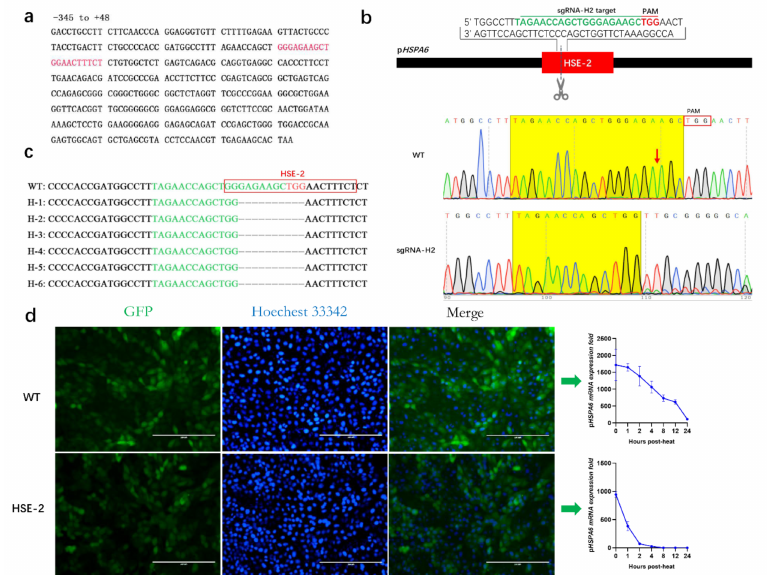
Figure 3. Effect of HSE-2 on the expression of p HSPA6 . ( a ) The position of HSE-2 was located in the p HSPA6 promoter. ( b ) Strategy of sgRNA-H2 knock-in into p HSPA6 ; and the cutting efficiency of sgRNA-H2 was evaluated using chromatograms. Red blocks and red arrows represent PAMs and cleavage sites, respectively. ( c ) Diagram of positive clone HSE-2 after pLB vector cloning. ( d ) Fluorescence microscopy and qPCR analysis of p HSPA6 expression in WT and positive clone cells (data show the mean ± S.E.M. in triplicate